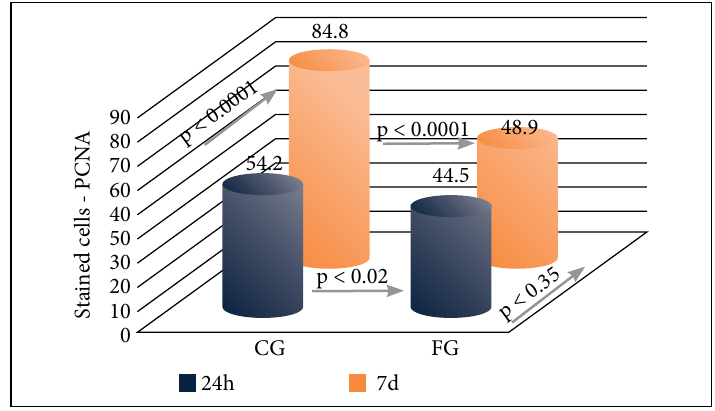
Figure 4 - Liver regeneration by PCNA stained hepatocytes. Statistical comparisons between the control (CG) and 5-fluorouracil (FG) groups at 24 h and 7 days. Blue: 24-h subgroups; Red: 7-day subgroups. Mann–Whitney and Student’s t tests (p).